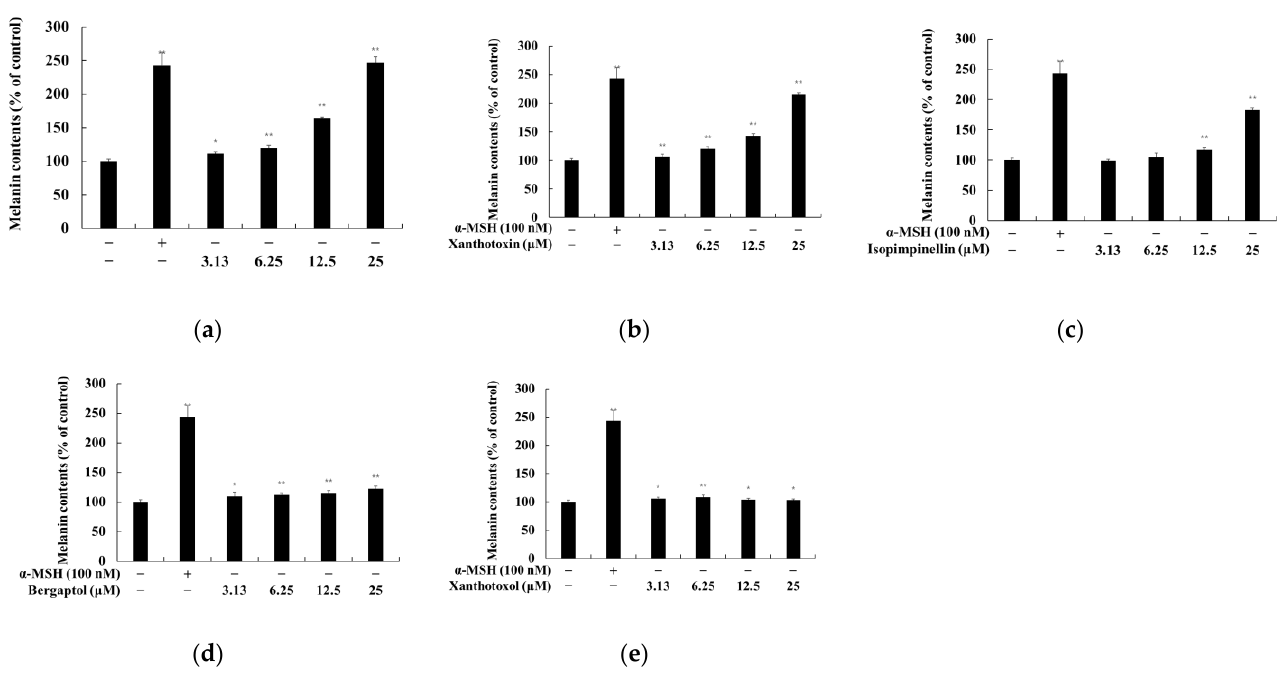
Figure 3. Effects of psoralen derivatives on the melanin content in B16F10 melanoma cells. The cells were treated with psoralen derivatives (3.13, 6.25, 12.5, and 25 μM) and α -MSH (100 nM) for 72 h. Melanin content of B16F10 cells subjected to ( a ) 5-methoxypsoralen (bergapten), ( b ) 8-methoxypsoralen (xanthotoxin), ( c ) 5,8-methoxypsoralen (isopimpinellin), ( d ) 5-hydroxypsoralen (bergaptol), and ( e ) 8-hydroxypsoralen (xanthotoxol). The results are presented as the mean ± SD of three independent experiments. * p < 0.05; ** p < 0.01 vs. the untreated group.